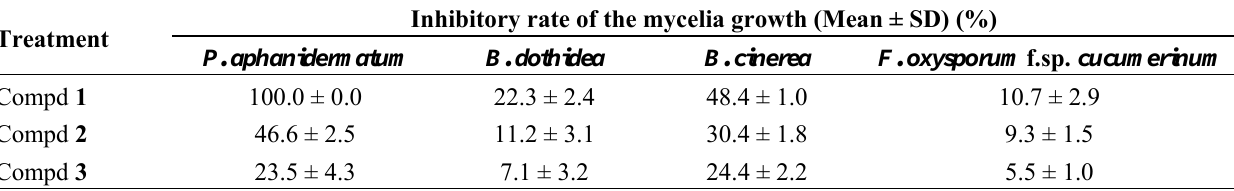
Table 3. Mycelia growth inhibition of the compounds 1 - 3 against four phytopathogenic fungi. Treatment